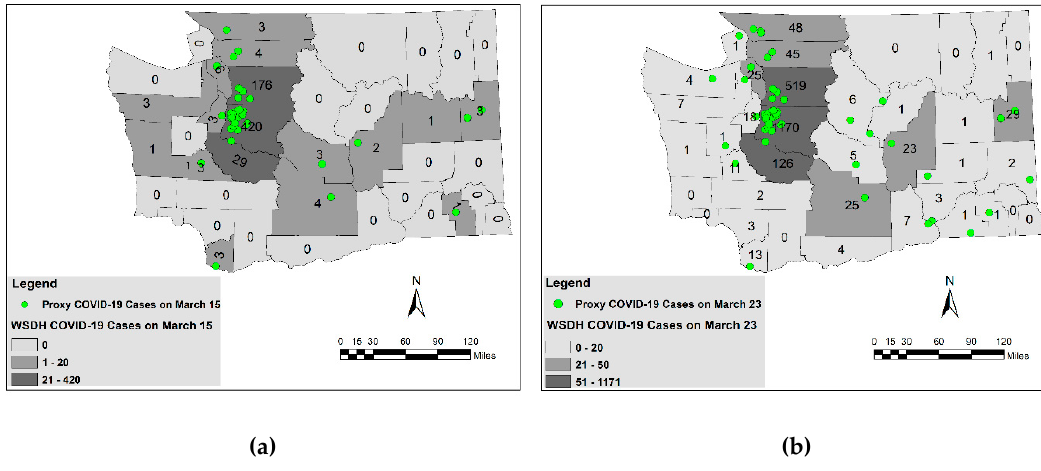
Figure 4. Proxy COVID-19 locations overlaid on top of WSDH COVID-19 case counts per county: ( a